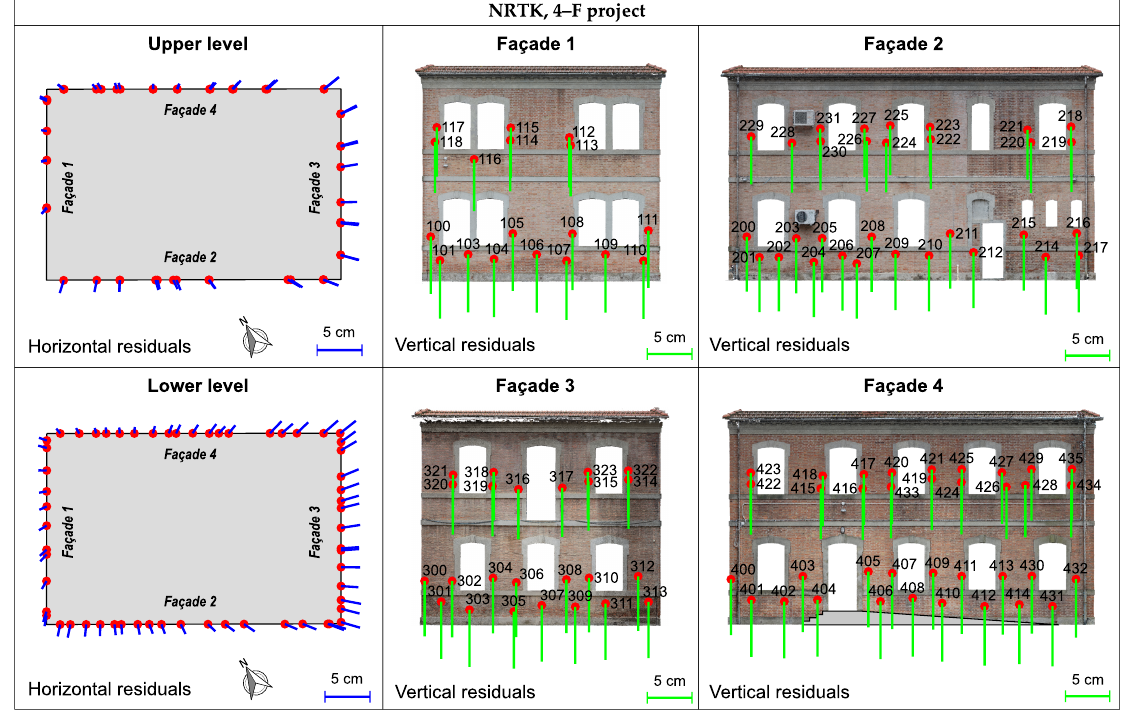
Figure A1. Horizontal and vertical residuals for NRTK image dataset processed as an overall block